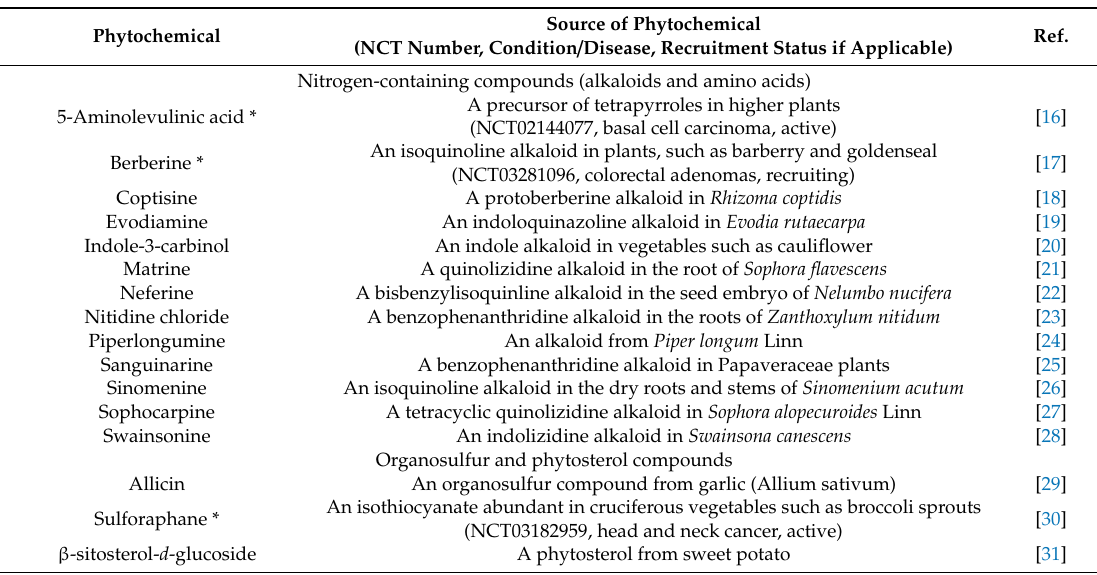
Table 1. The list of phytochemicals and derivatives currently tested in preclinical studies and clinical